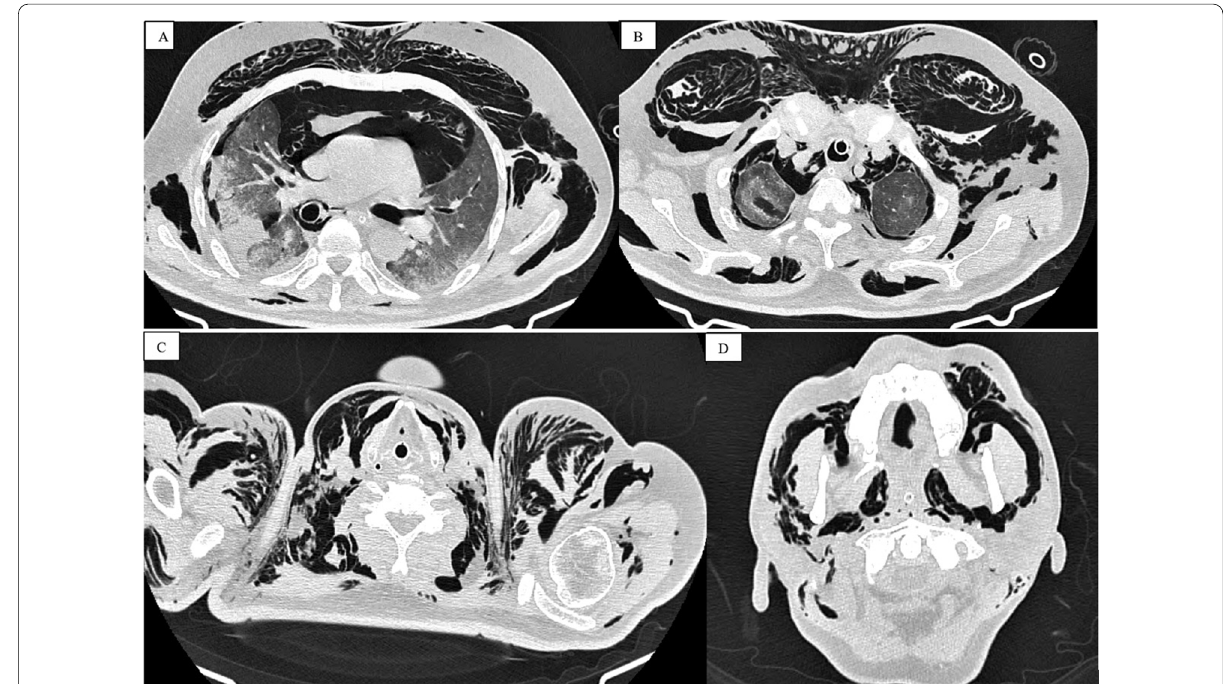
Fig. 2 A 56-year-old male was brought to our hospital with worsening shortness of breath. The patient was moved to the critical care unit after failing to maintain a SpO2 of over 87 percent on the fourth day of hospitalisation (ICU). Within 3 days of intubation, axial CT thorax sections indicated severe barotrauma in the form of pneumomediastinum, pneumothorax, and subcutaneous emphysema ( A , B and C ). Subcutaneous emphysema had also spread to the neck and face ( D